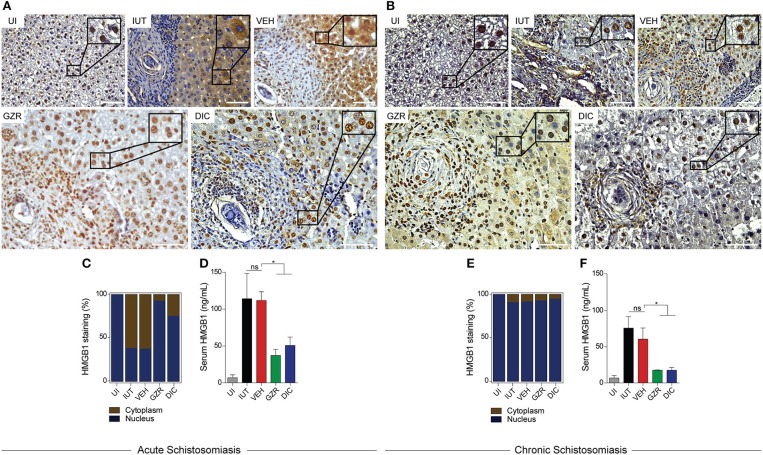
Secretion of HMGB1 is restricted in the acute phase of schistosomiasis. (A,B) Representative photographs of immunohistochemistry (from 5 animals per group) of HMGB1 in hepatic tissues after acute or chronic schistosomiasis. Insets show nuclear or cytoplasmic HMGB1 in an amplified manner. Photographs presented at 40x magnification. Scale bar = 50 μm. Note that both inhibitors prevented HMGB1 secretion only in the acute schistosomiasis (A, GZR and DIC). (C,E) Quantification of the immunohistochemistry, showing the percentage of hepatocytes with HMGB1 in the nucleus (blue) or cytoplasm (brown). (D,F) Sera levels of HMGB1 of mice with acute (40 animals) or chronic (15 animals) schistosomiasis. The results were presented as the mean ± SEM and were tested by ANOVA Tukey's multiple comparisons test. *P < 0.05 was considered statistically significant; ns—not significant. The P-values for all comparisons are available in Table S3. Legends of the experimental groups are as depicted in Figure 2.